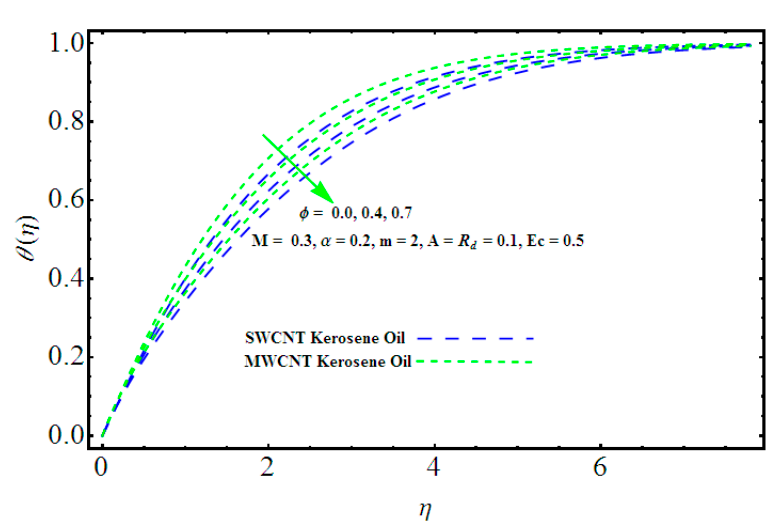
Figure 9. Impact of 𝜙 on velocity 𝜃(𝜂) .